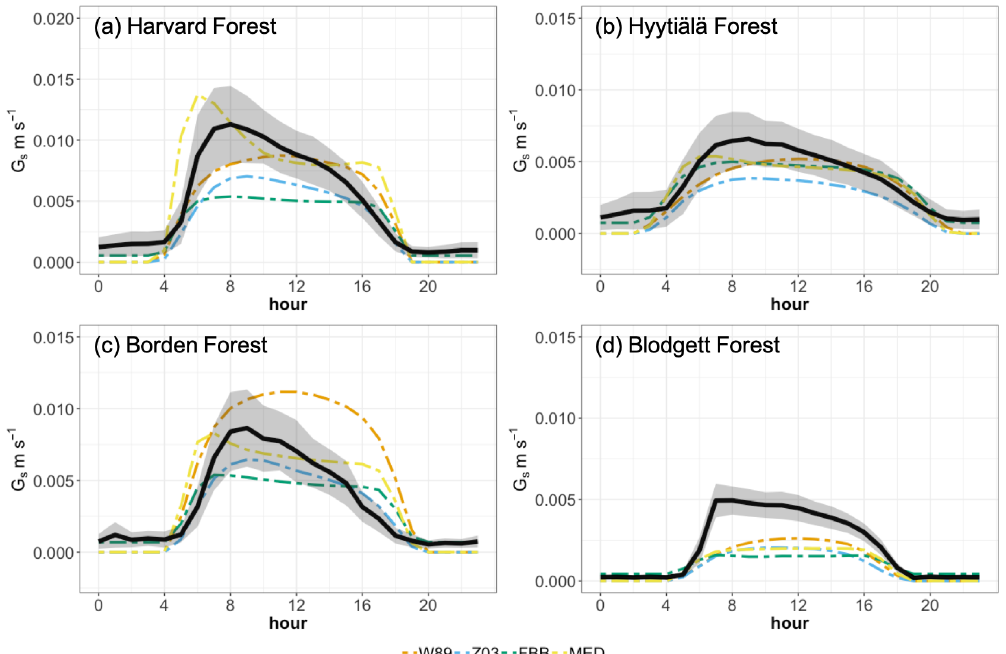
Figure 4. Simulated and observed diurnal cycles of canopy stomatal conductance for ozone during summer at the four long-term measure- ment sites. Black lines indicate G s derived with the P-M method. Shaded envelope shows standard deviation of summertime average hourly G s . Colored solid lines indicate simulated stomatal conductance using multiplicative and photosynthesis-based stomatal